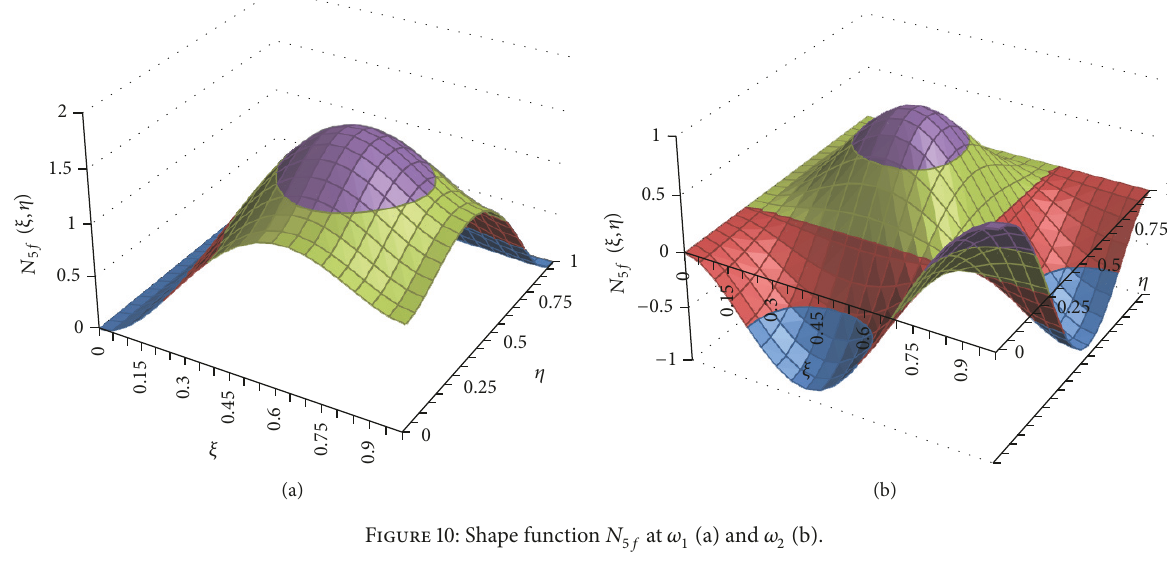
Figure 10: Shape function 𝑁 5𝑓 at 𝜔 1 (a) and 𝜔 2 (b).